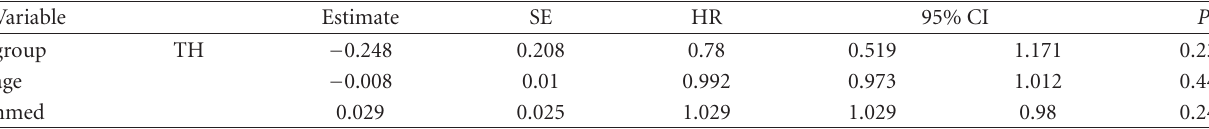
Table 8: Results from cox proportional hazards modeling of time to ED use.